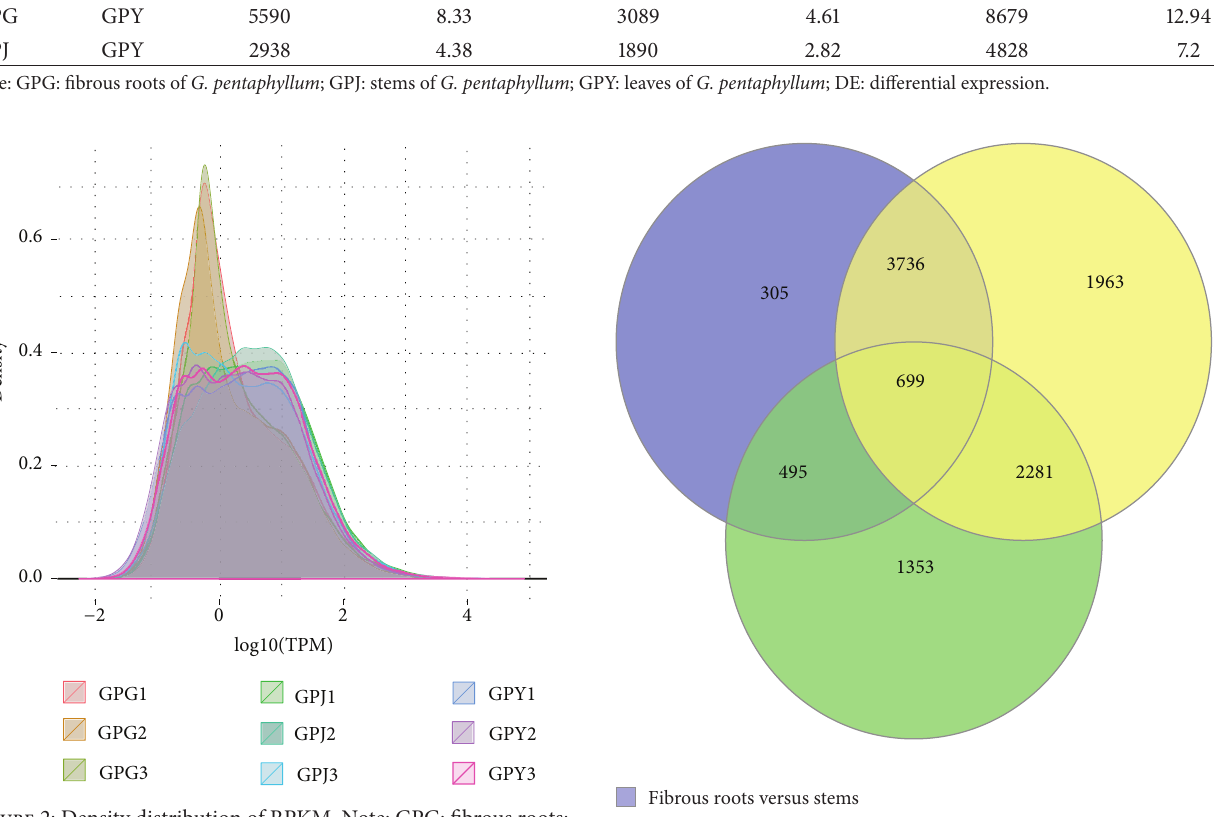
distribution of gypenosides in G. pentaphyllum. Leaves had the highest content (3.189%) of gypenosides of all samples (Table 5), and the content of gypenosides in stems (0.365%) or fibrous roots (0.172%) was much lower than the leaves. A correlation coefficient ( 𝑅 2 ) of 0.996 in the standard curve indicates that our result was accurate and reliable (Figure